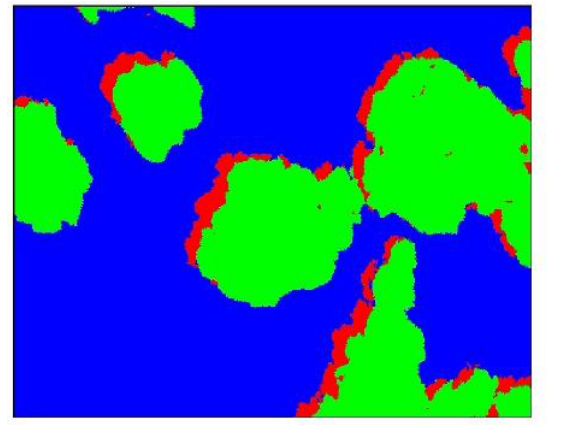
Figure 6: A part of VHR imagery classified by SVM optimized by the Taguchi method.